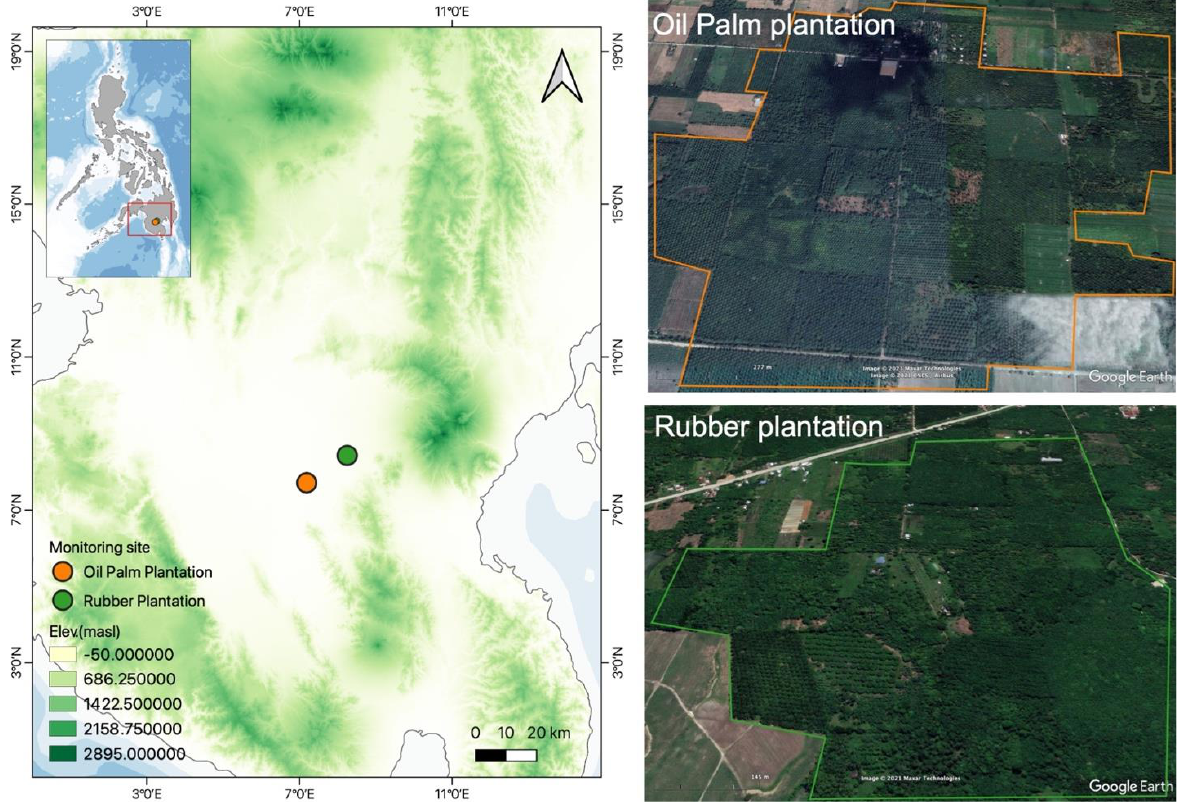
Figure 1. Map showing the monoculture oil palm and rubber plantation (right: marked aerial view) monitoring sites in North Cotabato province, Southern Philippines.